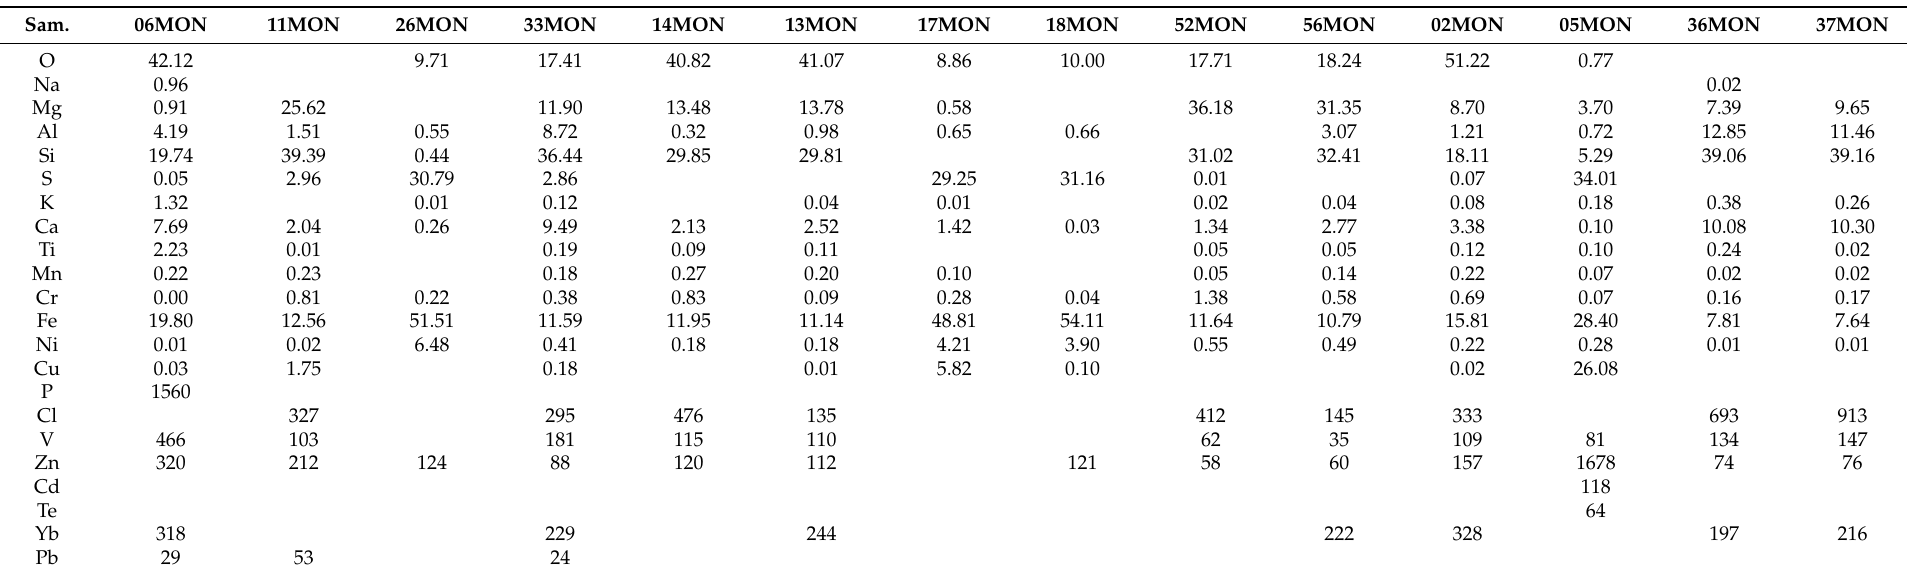
Table 1. Chemical composition of the selected rocks from Monchepluton (mine element in [wt.%], trace in [ppm]) (as standards, Loam 7004 and San Joaquill soil were used, see Tables 2 and